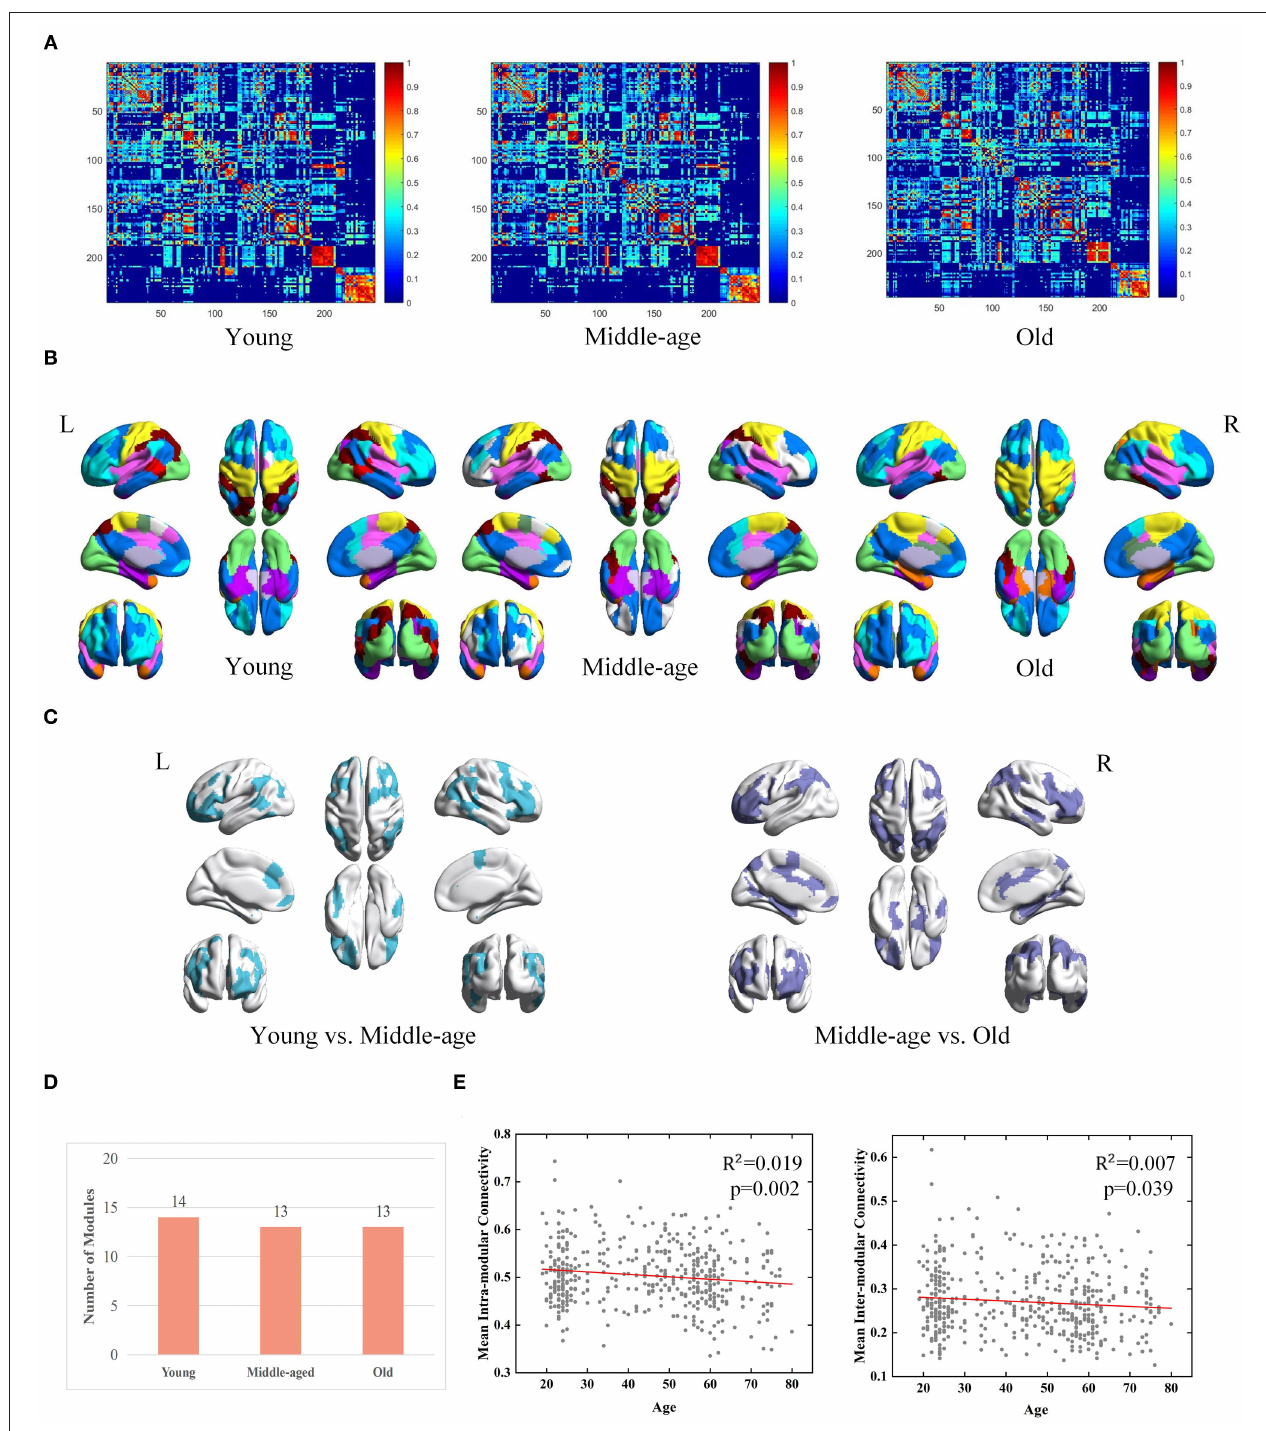
FIGURE 3 | Age-associated differences in functional brain networks across three groups derived from MPP-guided method, including (A) group-level weighted networks, (B) modular structures (different colors represent different modules), (C) Brain regions belonging to different modules (young group vs. middle-age group and middle-age group vs. old group), (D) number of modules, and (E) age-associated trajectories of the mean intra- and inter-modular connectivities.